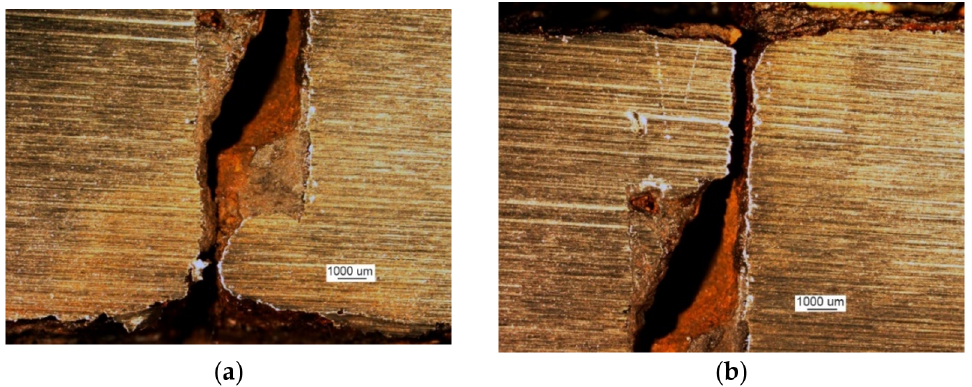
Figure 42. ( a , b ) Part of the location where the cracks merged (handy-size bulk carrier 30185 DWT). Stereoscopic optical microscopy.